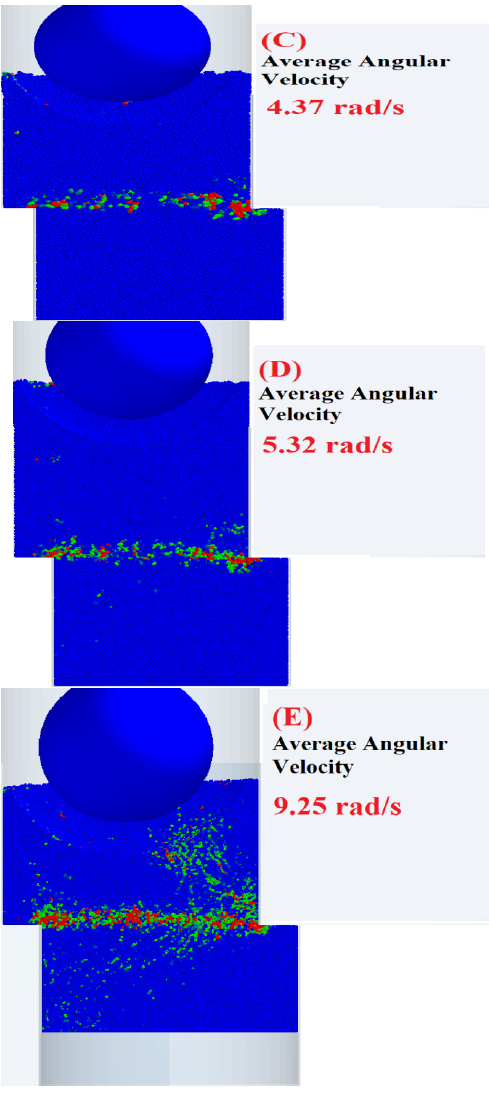
Figure 13 Rotation of particles at 15% shear strain for (SI= 150%, 125%, 100%, 75%, 50% respectively) at 30kPa normal stress